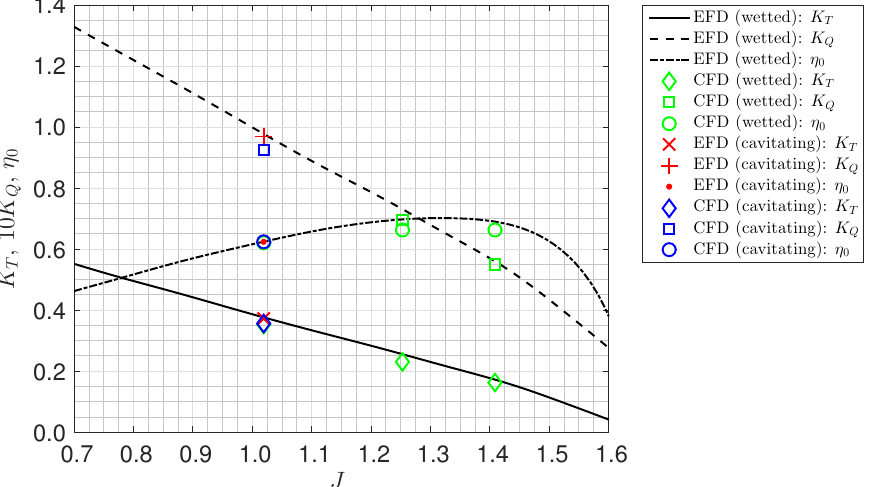
Figure 7. Comparison of global propeller performance characteristics. CFD: computational fluid dynamics; EFD: experimental fluid dynamics.